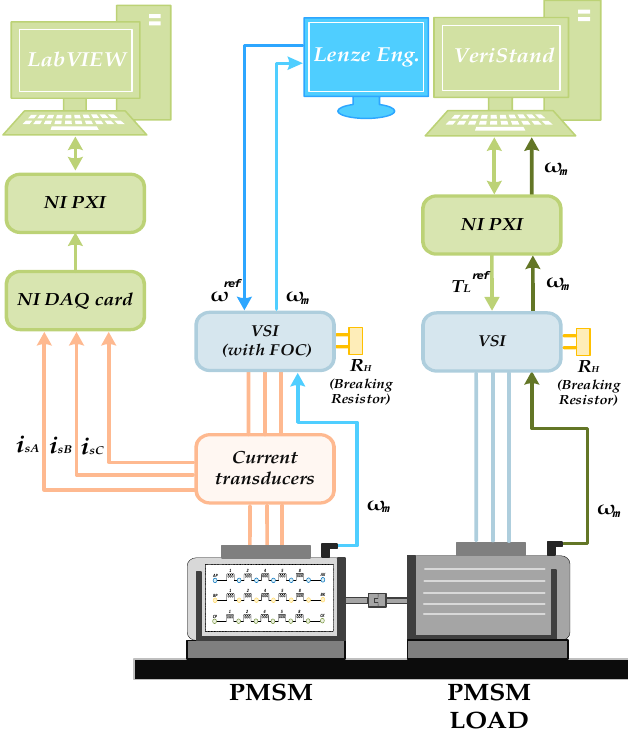
Figure 8. Block diagram of the experimental setup.